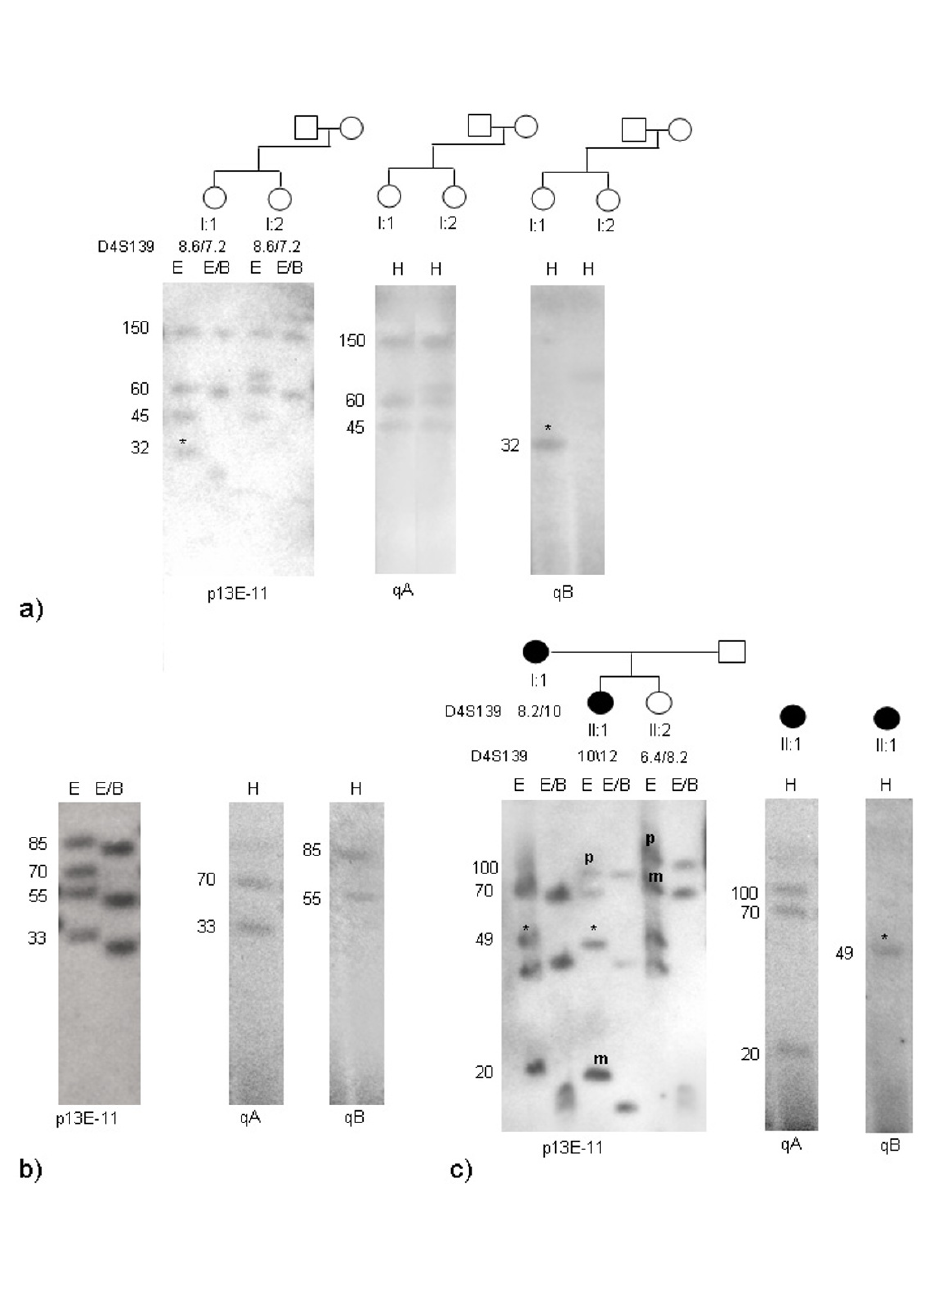
Figure 6 10q alleles with qB telomere . Allelic pattern of individuals carrying 10q alleles with a qB type telomere. a) The segregation study with the D4S139 probe demonstrates that the two sisters inherited the same 4q alleles of 150 and 60 kb. I:1 shows a tri- somic pattern with a BlnI-resistant 10q of 32 kb (*) and a standard 10q of 45 kb. The analysis of the telomeric sequences reveals that the variant 10q allele of 32 kb has a qB telomere. The two 4q alleles and the standard 10q allele of 45 kb have qA telomeres. b) The patient is trisomic and carries a FSHD allele of 33 kb and a standard 10 q allele of 70 kb with a qA telomere. We can not distinguish the 10q variant allele from the 4q standard alleles. Since both the 85 kb and 55 kb show a qB telomere, we deduce that the variant 10q allele carries a qB telomere. c) The 4q short allele of 20 kb segregates with FSHD in the family. The affected daughter (II:1) is trisomic and inherited from the mother (I:1) both the FSHD-linked 4q of 20 kb and the BlnI- resistant 10q allele of 49 kb (*) and from the father a standard 10q allele of 70 kb and a 4q standard allele of 100 kb. The anal- ysis of the telomeric sequences shows that the variant 10q allele of 49 kb has a qB telomere, while the 10q standard allele of 70 kb and both 4q alleles of 100 and 70 kb have a qA telomere. The 10q variant allele of 49 kb is represented in figure 5